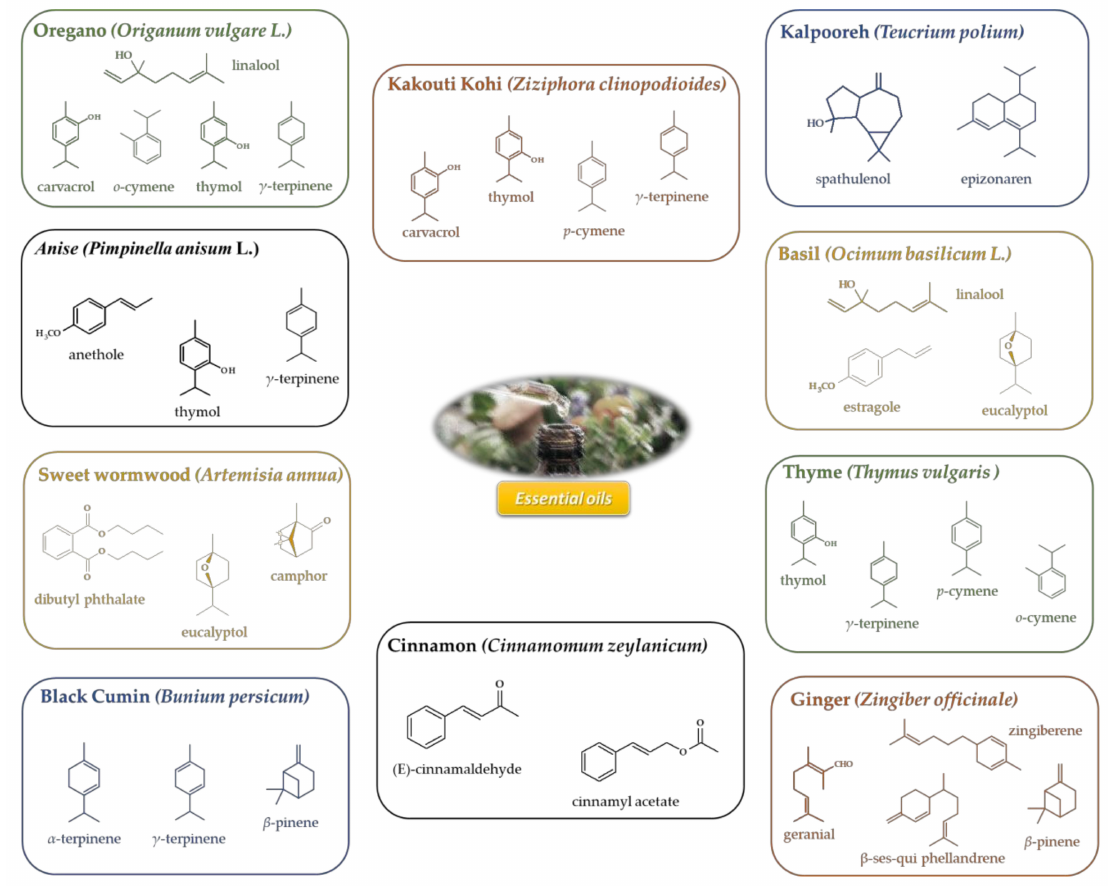
Figure 1. Selected essential oils (Eos) and their main